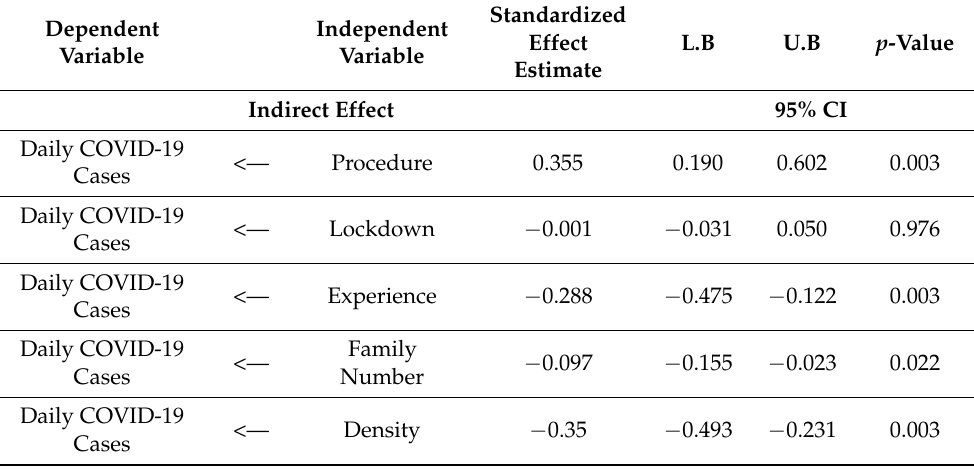
Table 7. Path Analysis on socio-economic and mitigation measure determinants of COVID-19 daily